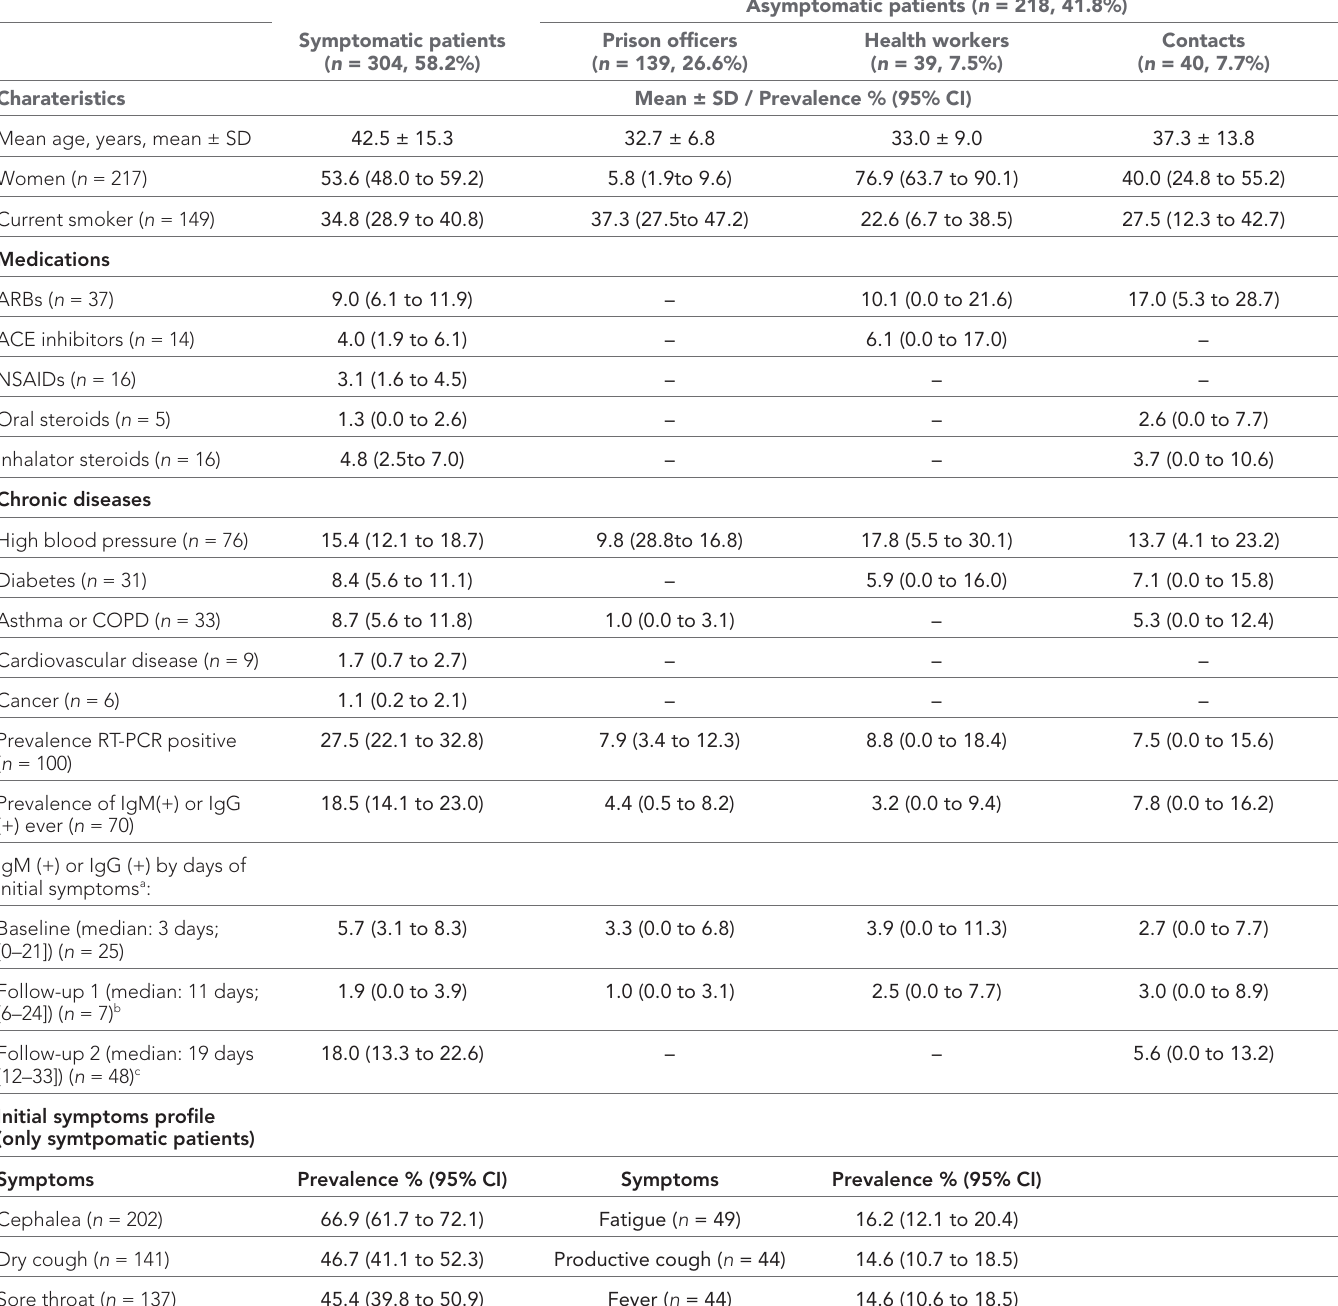
Table 1 Characteristics of study participants ( n = 522)